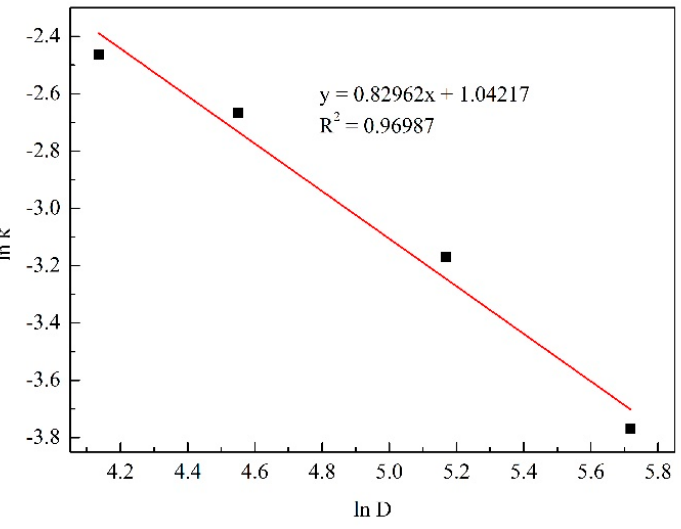
Table 3. Fitting results between ln[ − ln(1 − η )] and lnt under different acid concentrations. Initial Acid Concentration Figure 11. Plot of lnk vs. lnD in alkali fused SCC leaching process. Figure 11. Plot of lnk vs. lnD in alkali fused SCC leaching process. Results shown in Figure 5(right) were substituted into Equation (24), and the variations of ln[ − ln(1 − η )] with lnt were plotted for initial acid concentrations in Figure 12. The linear fitting regression equations and correlation coefficients are listed in Table 3. The straight lines in Figure 12 and fitting curve correlation coefficients R 2 in Table 3 showed good linear correlations between ln[ − ln(1 − η )] and lnt under different initial acid concentrations.